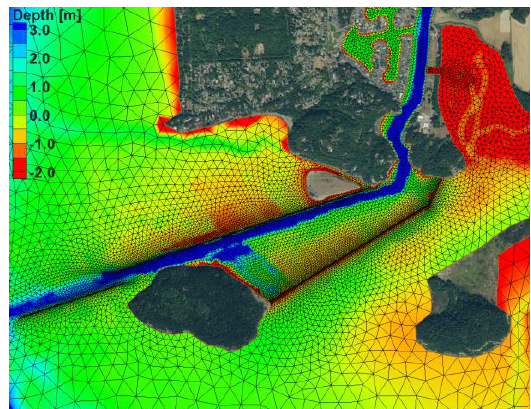
Figure 8. Close-up of the model grid and bathymetry used in baseline (or existing conditions) simulation. Note—color contours indicate depths (negative elevations) relative to NAVD88 datum. We then modified the baseline grid to generate the following two scenarios of interest shown in